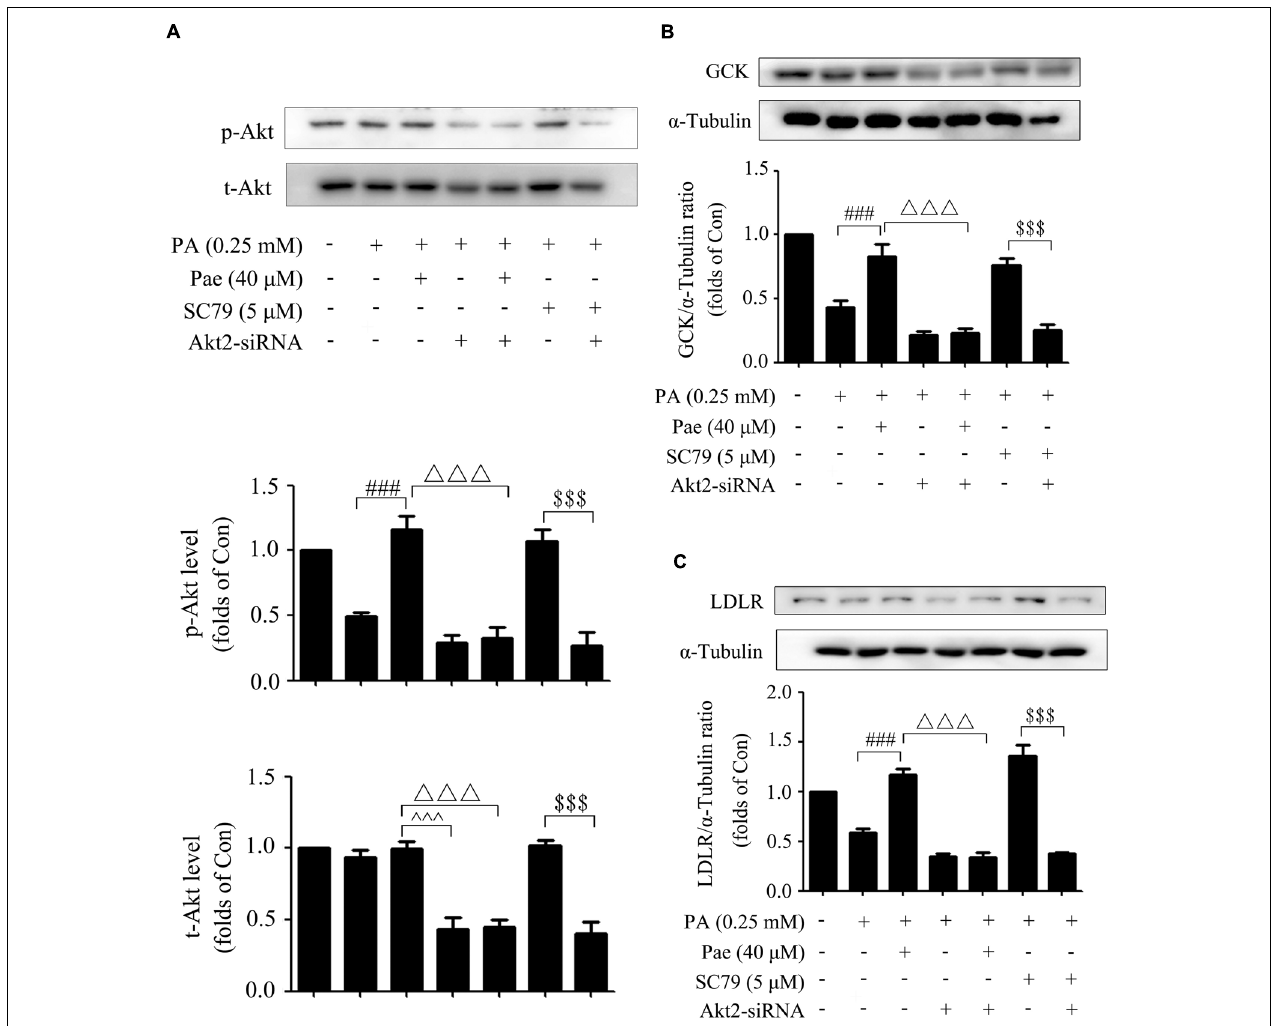
FIGURE 6 | The effects of Akt2-siRNA on GCK, LDLR and p-Akt. (A) Paeonol-induced levels of t-Akt and p-Akt were assessed after treatment with Akt2-siRNA under insulin resistant conditions. (B,C) Akt2-siRNA abolished the effects of paeonol on GCK and LDLR. All experiments were performed at least three times with similar results. ### p < 0.001 vs. PA (0.25 mM); (cid:52)(cid:52)(cid:52) p < 0.001 vs. PA + Pae; $$$ p < 0.001 vs. PA + SC79; ∧∧∧ p < 0.001 vs. PA +